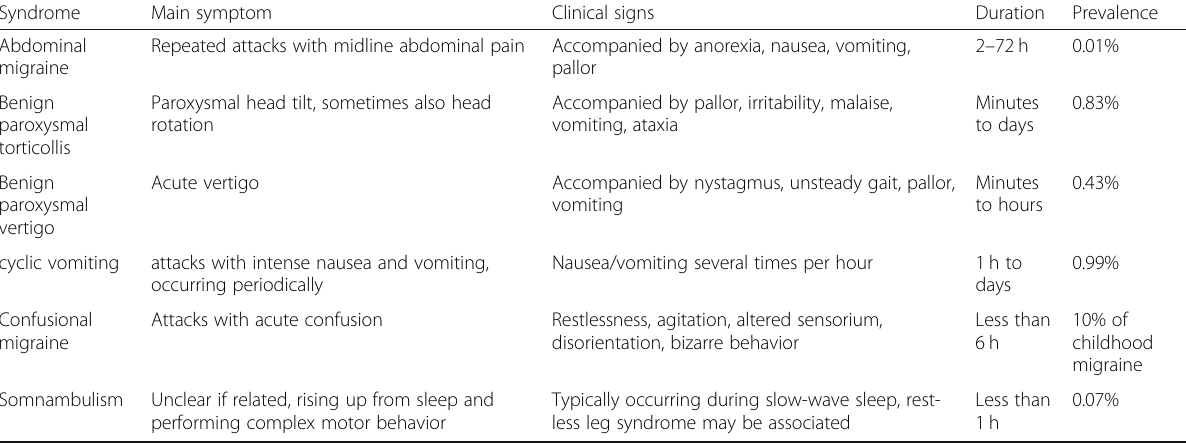
Table 1 Migraine-related syndromes (modified from [35, 45])